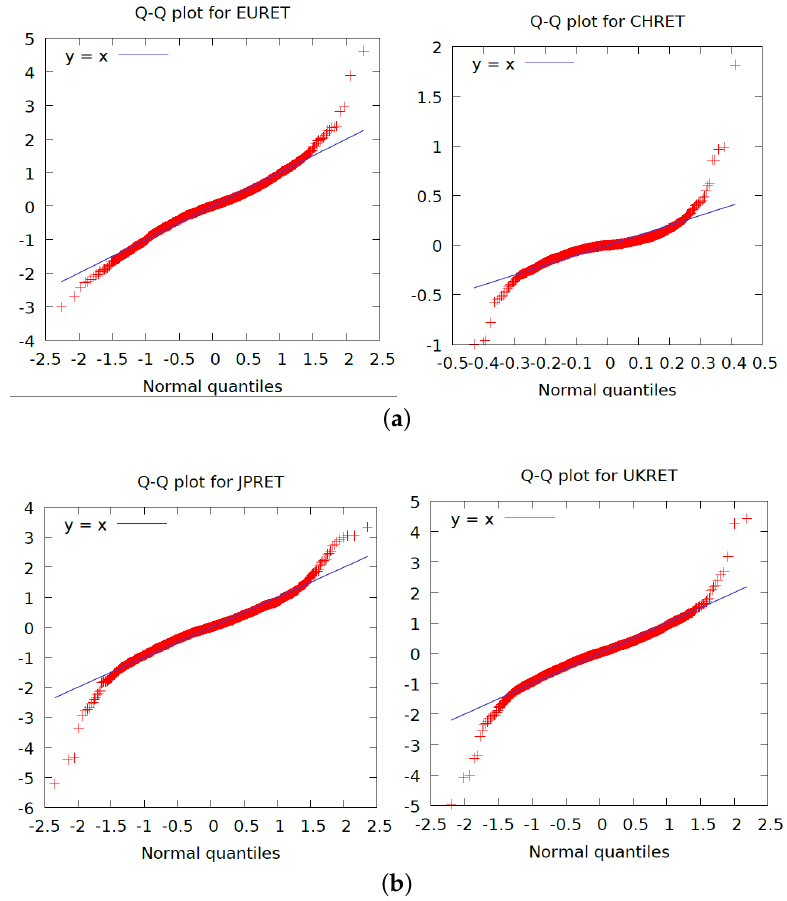
Figure 2. QQ Plots. ( a ) EEU and China; ( b ) Japan and